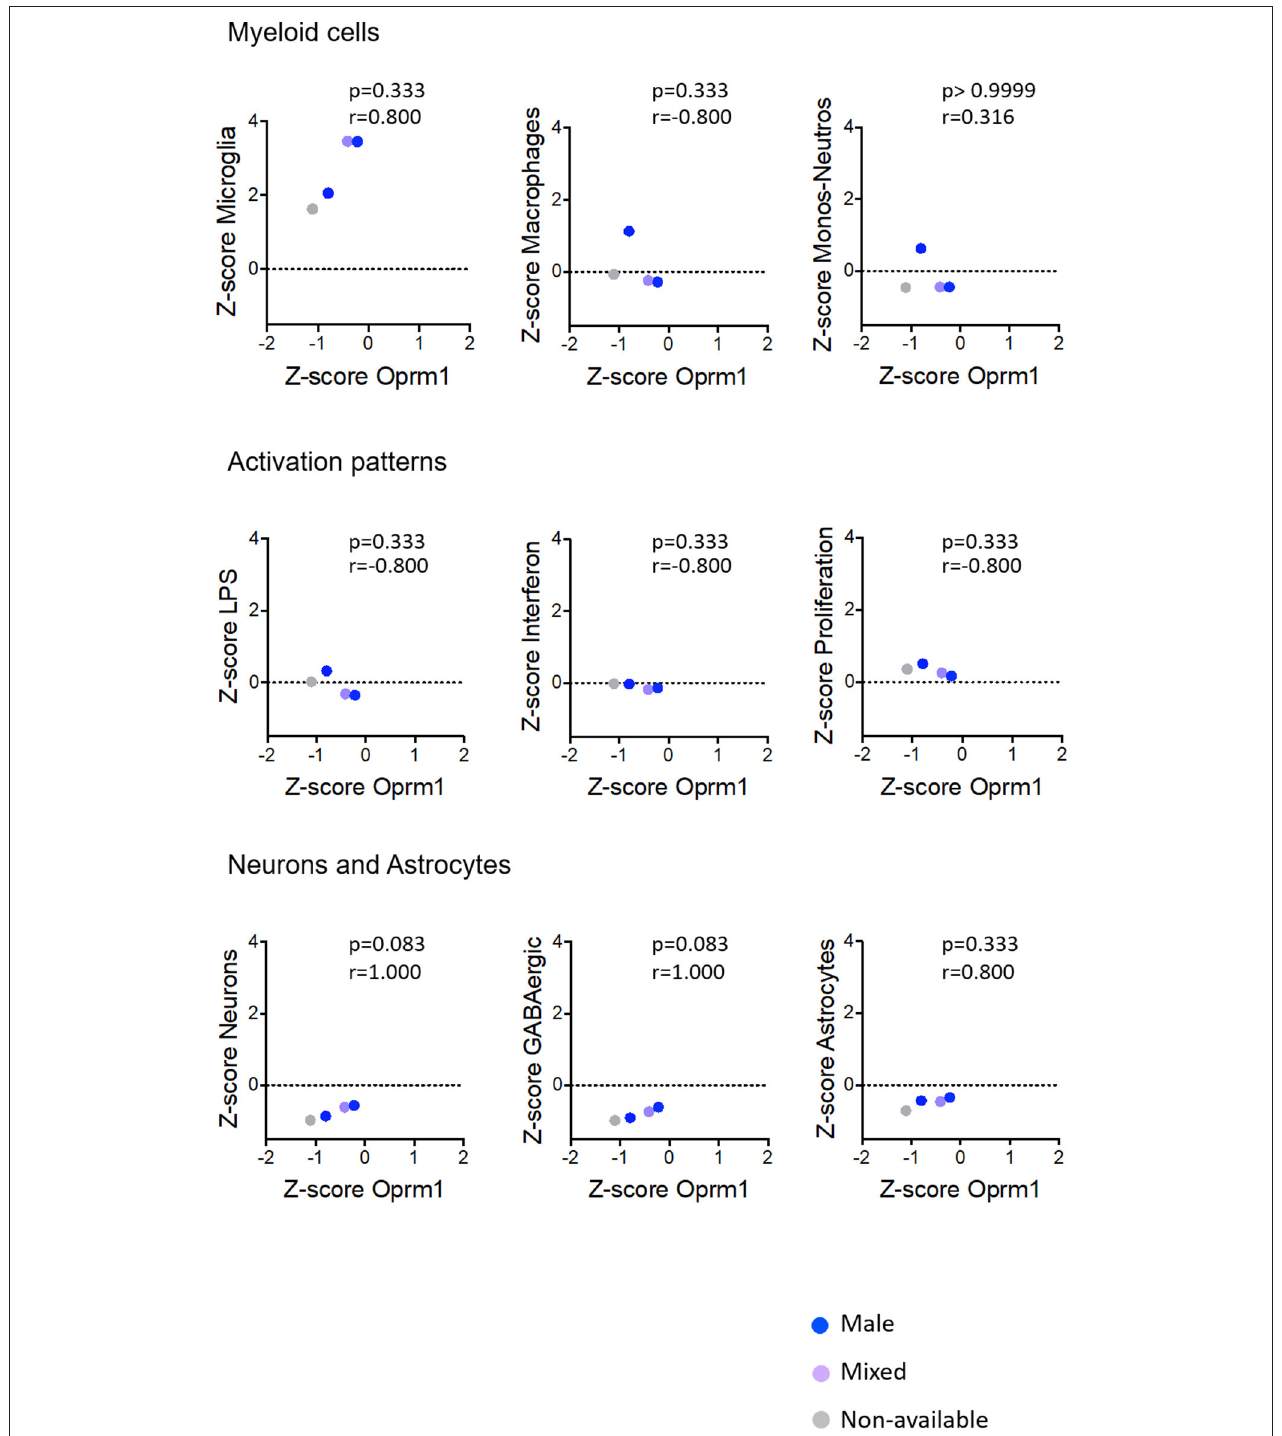
FIGURE 7 | Correlation of Oprm1 gene expression within the Myeloid cells, Activation patterns and Neurons and Astrocytes gene clusters in mouse hippocampus datasets. There is no correlation between Oprm1 expression and all the gene clusters investigated in the mouse hippocampus datasets ( p > 0.05, ns). Although Oprm1 expression seems to have a strongly positive correlation with the Neurons and Astrocytes gene clusters ( r = 1 and r = 0.800, respectively) this is not statistically significant ( p > 0.05, ns). All correlations were determined with the Spearman’s correlation test.